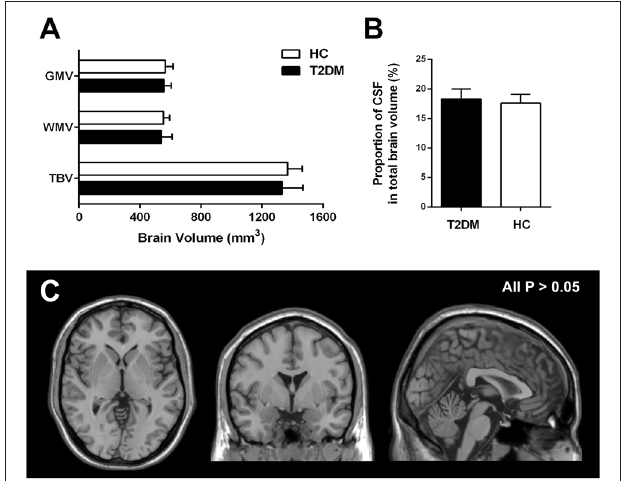
FIGURE 1 | Group difference based on voxel-based morphometry (VBM) analysis. (A,B) Difference of the mean gray matter volume (GMV), white matter volume (WMV), total brain volume (TBV) and proportion of cerebrospinal fluid (CSF) in type 2 diabetes mellitus (T2DM) and healthy control (HC) subjects. (C) Difference of regional atrophy between T2DM and HC groups. Neither whole brain (A,B) nor regional brain (C) volume reduction was observed in T2DM patients. All P >